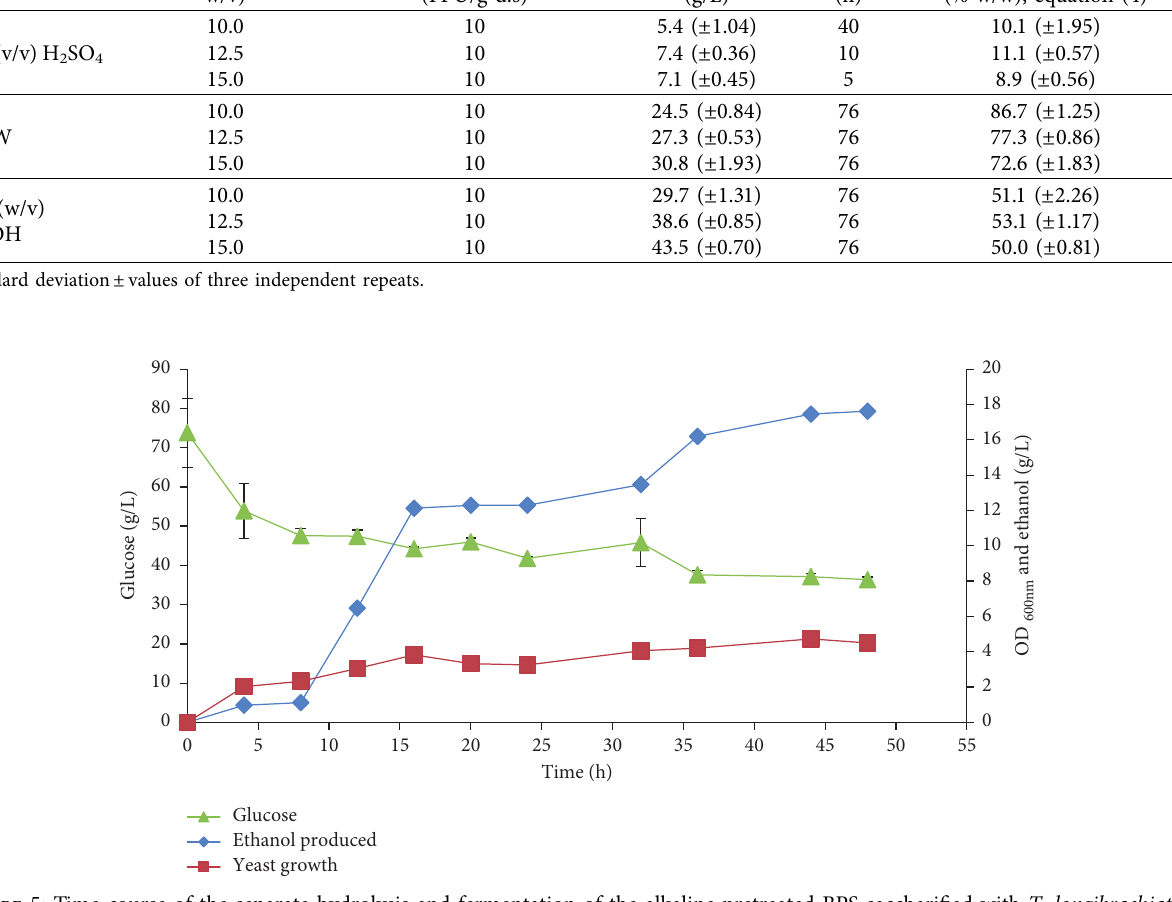
Table 4: Summary of enzymatic saccharification of pretreated banana pseudostems at varying solid loadings by crude enzymes produced by Trichoderma longibrachiatum LMLSAUL 14-1. Pretreatment